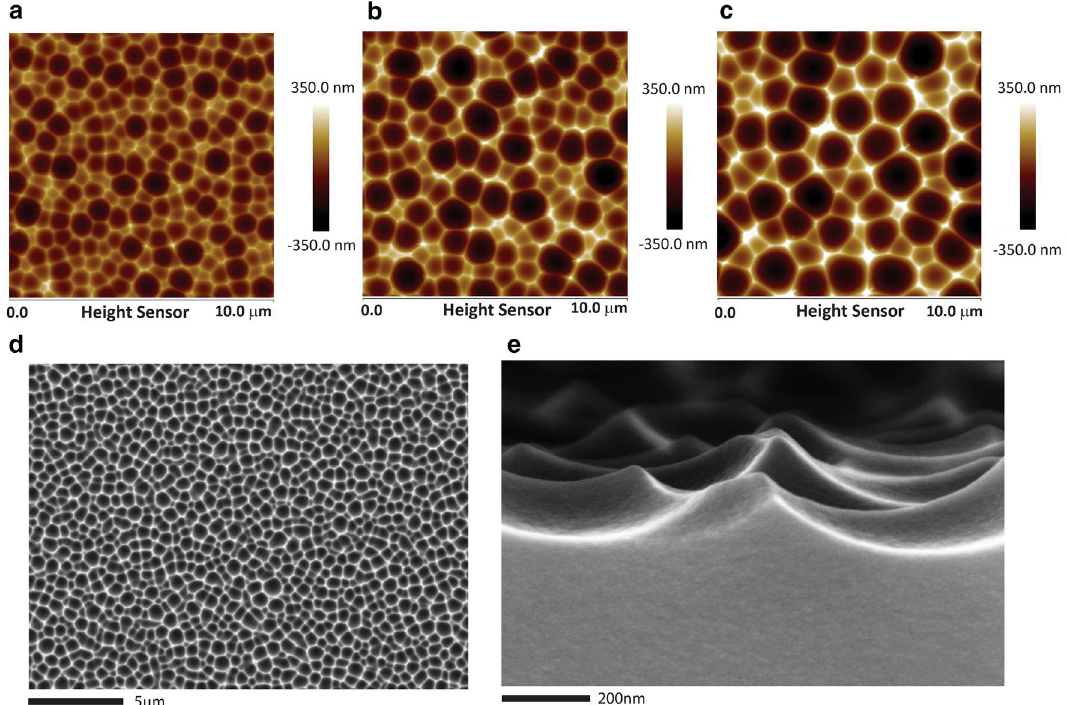
Figure 2. SEM and AFM images of textured aluminosilicate glass surfaces (Glass A) after citric acid and NaOH treatments. ( a )–( c ) 10 µm x10µm AFM images of textured Glass A treated in 20 wt% citric acid at 95 °C and a follow-up NaOH washing. The image color scale is mapped to quantitative height data. The citric acid treatment times for images ( a )–( c ) are 10, 13.5, and 16 h, respectively. The textures on ( a )–( c ) possess continuous concave features with diameters of 0.8, 1.2, and 1.5 microns, and surface roughness (Ra) values of 65.7, 94.8, and 120.3 nm. These textured glasses (with one-side texture) contribute transmittance haze values of 19.5%, 38.8%, and 59.0%. Longer acid treatment time leads to larger surface features, higher surface roughness (Ra), and higher haze values. ( d ) SEM image of the textured surface also shown in image ( a ). The scale bar is 2 microns at 5kx magnification. A uniform texture surface is observed. ( e ) SEM cross-section view of the 10-h treated surface [same surface of image ( a , d )]. The scale bar is 200 nm at 100kx magnification. As shown by the SEM images, the textured surface consists of pointed peaks connected by curved ridges, and concave valleys surrounded by the peaks and